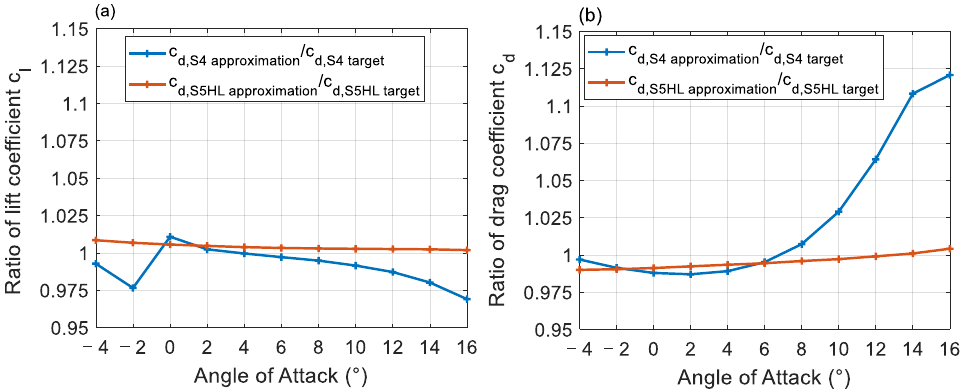
Figure 17. Effect of deviation between target aerofoil and achieved approximation on lift ( a ) and drag ( b ) coefficients.